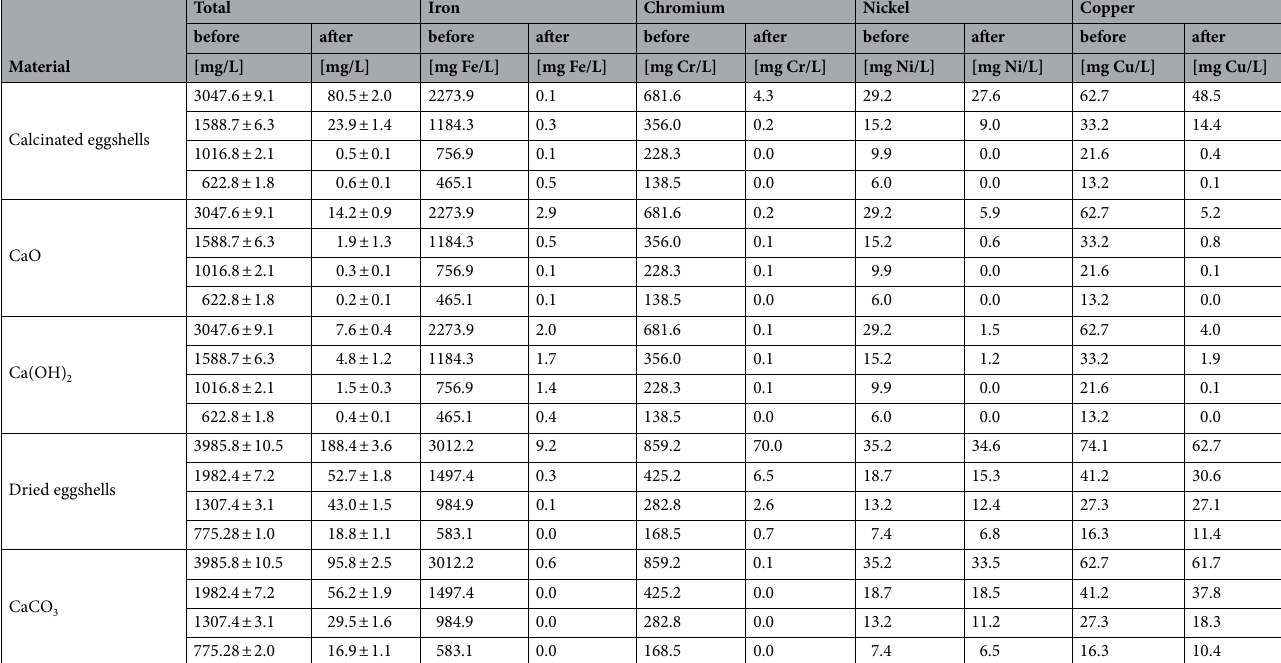
Table 4. Concentration of metal ions Fe(III), Cr(III), Ni(II), and Cu(II) before and after